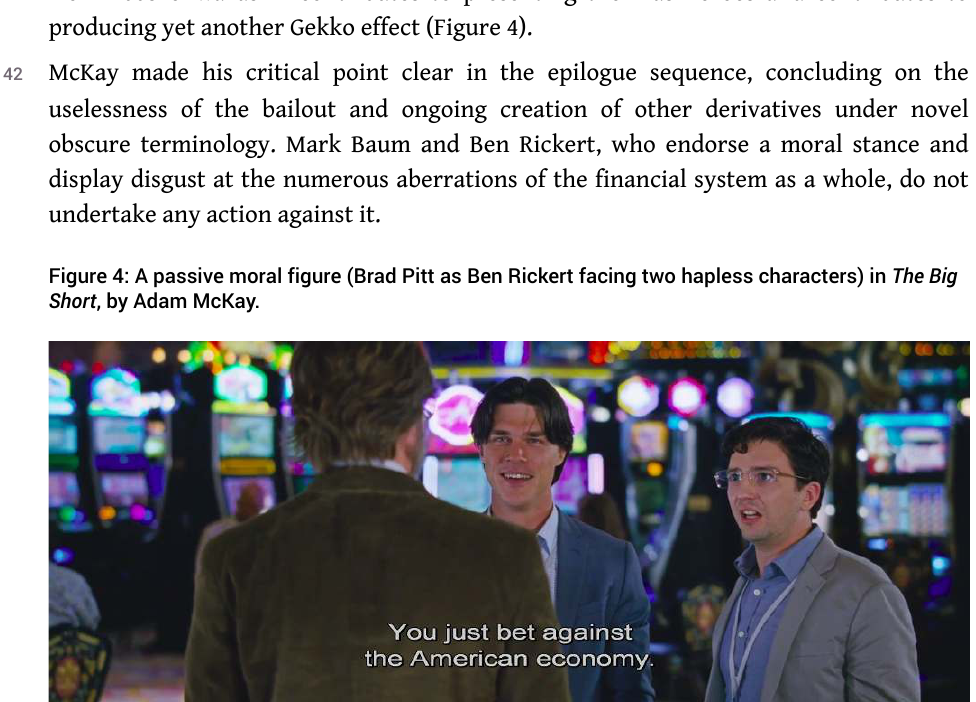
Source: The Big Short , by Adam McKay (screen